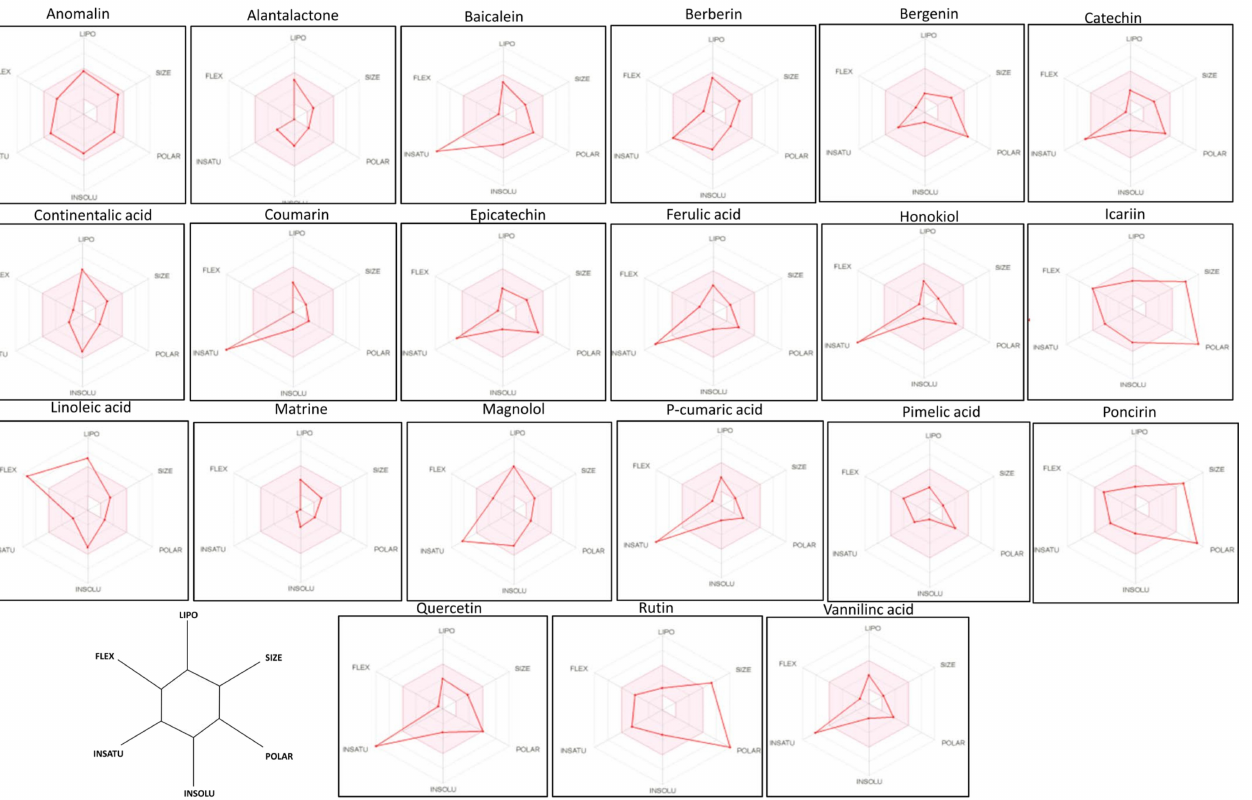
Figure 2. The bioavailability radar analysis of the selected compounds using SwissADME software. The various properties that were assessed included LIPO, FLEX, SIZE, POLAR, INSOLU, and INSATU, which indicates the lipophilicity, Molecular weight, polarity, water solubility, etc. The compounds lying within the gray area reflect a good pharmacokinetic and drug